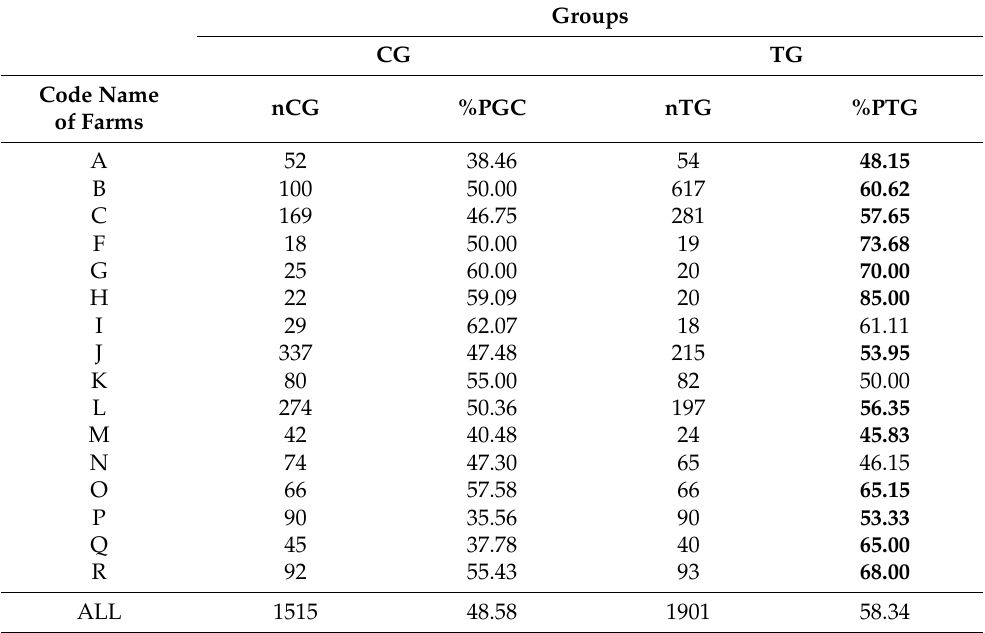
Table 3. Average of pregnancy rate and the number of cows on the control group (%PCG and nCG) and treatment Group (%PTG and nTG) by each farm (identified by code name) and by all farms. The font in bold format indicates a higher %P in TG. Groups CG